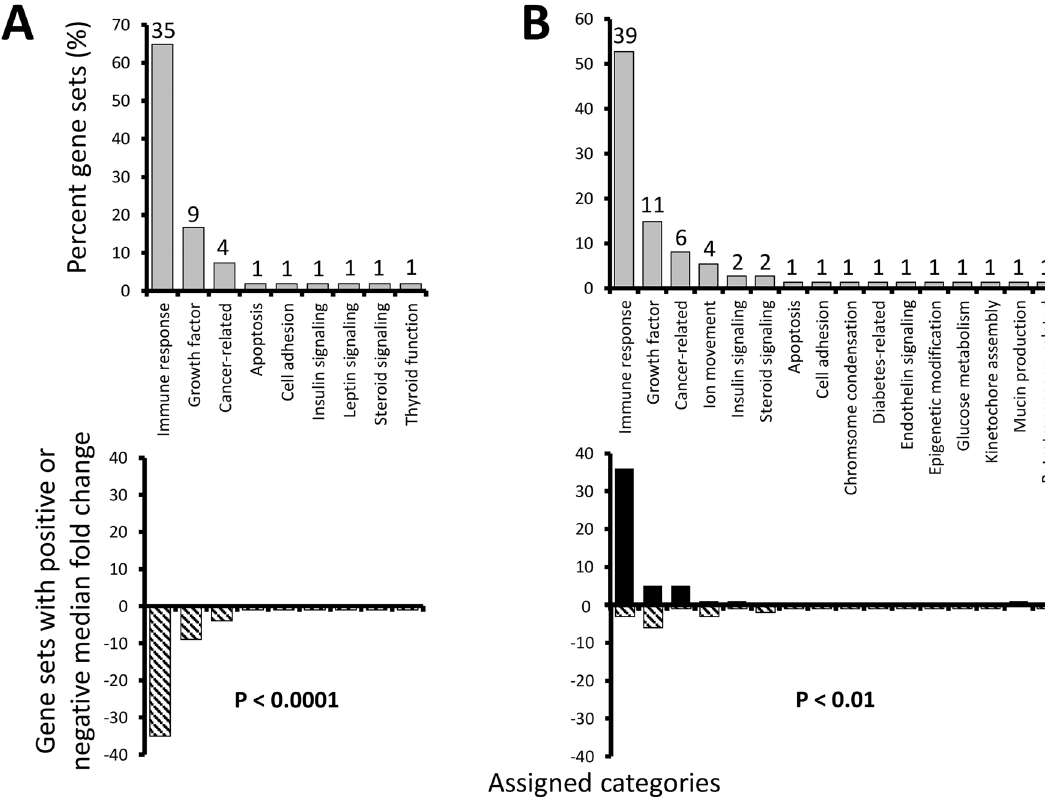
Figure 3. Percent gene sets (%) in the ovary ( A ) and hypothalamus ( B ) identified as highly significant (P < 0.01 with > 50% measured entries in a pathway) following PNX treatment were manually assigned functional categories (upper graphs). Numbers above gray bars refer to the total gene set number assigned to each category. Lower graphs identify the percent of gene sets (%) with overall positive (black bars) or negative (striped) median fold changes in each category. P values refer to significant differences from an expected equal frequency of gene sets with positive and negative